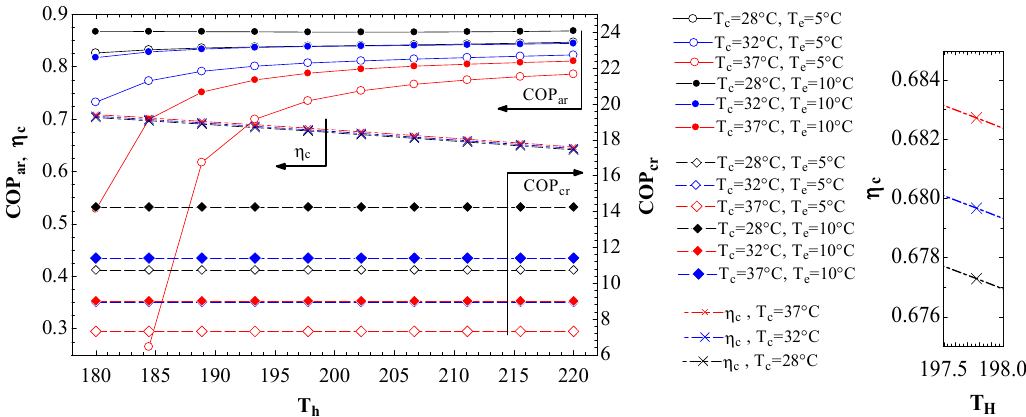
Figure 11. E ffi ciency of the solar collector and cooling systems, with respect to radiation in the solar concentrator.